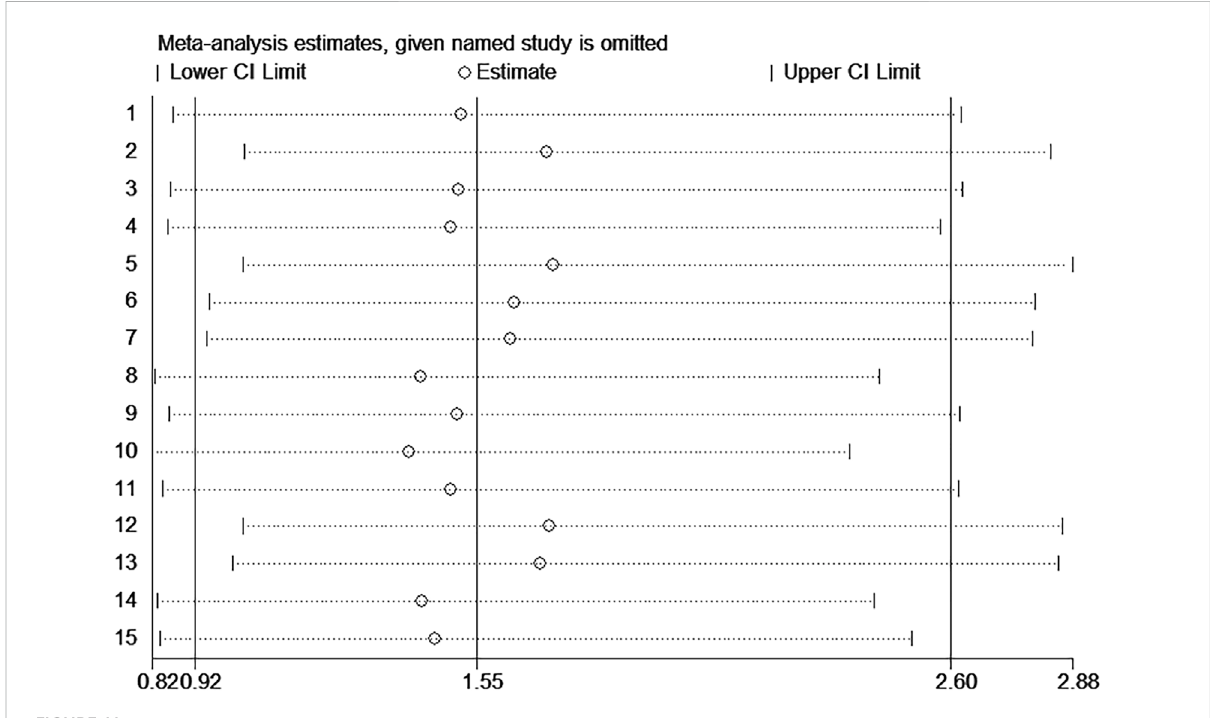
FIGURE 11 Sensitivity analysis of the miR-17 – 92 cluster for the prognosis of hepatocellular carcinoma